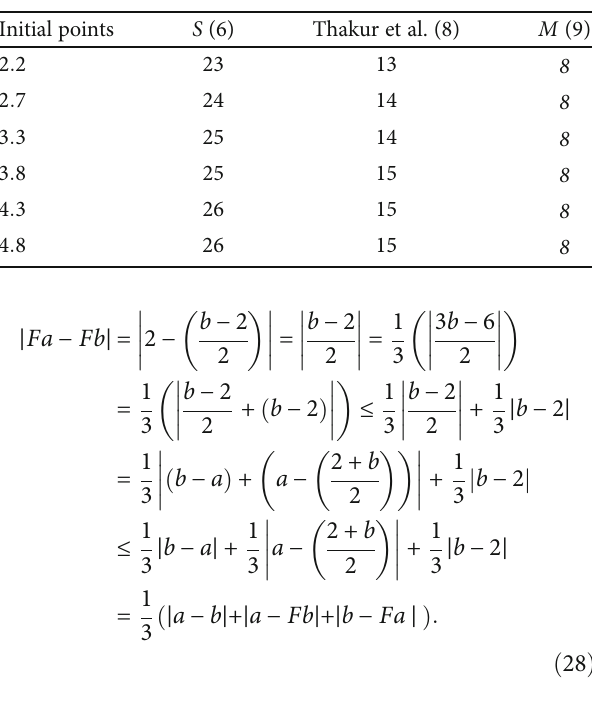
Figure 1: Convergence behavior of the M (red line), Thakur et al. (green line), Abbas and Nazir (yellow line), Agarwal et al. (blue line), Noor (cyan line), Ishikawa (magenta line), and Mann (black line) iterates for mapping F de fi ned in Example 1 where w 1 = 3 ffiffiffiffiffiffiffiffiffiffiffiffiffiffiffi ffiffiffiffiffiffiffiffiffiffiffiffi p p = 2 n / 7 n + 11 = 1/ 3 n + 9 Table 2: α and β . Number of n n iterations required to obtain the fi xed point.